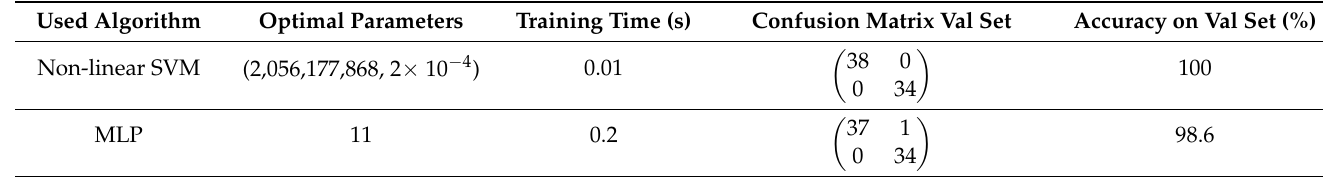
Table 3. The optimum pair (C*, γ *) for non-Linear SVM and the optimal number of neurons ( N *) for MLP. Training time, confusion matrices and accuracy obtained on the validation set for the two different ML algorithms trained with Magnitude only dataset.